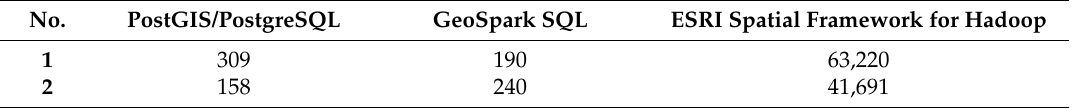
Table 13. Performance of range queries (in milliseconds).